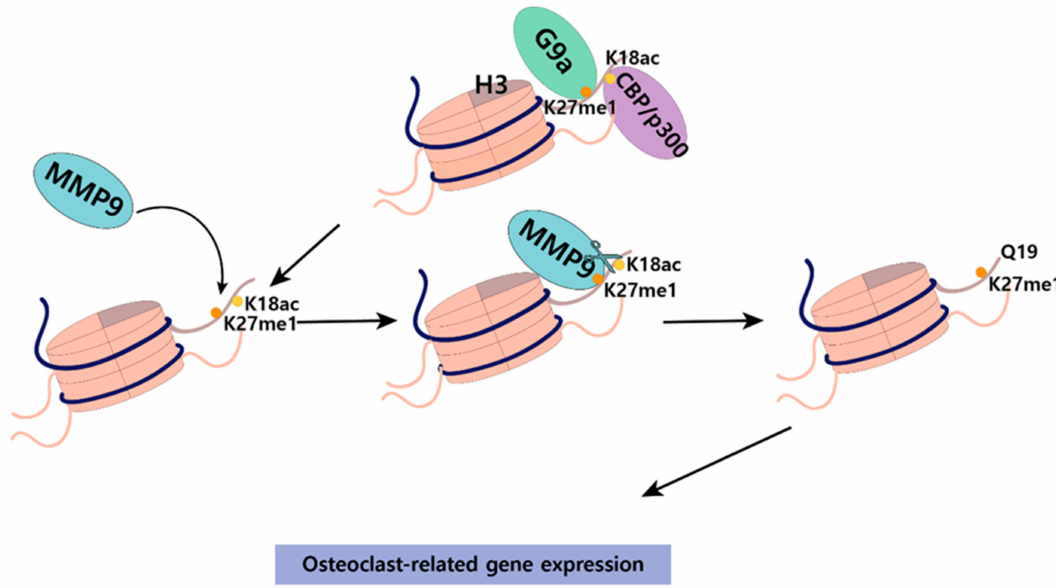
Figure 2. Schematic model of histone H3 N-terminal cleavage regulating osteoclastogenic target gene expression. G9a-mediated H3K27me1 at histone H3 enables matrix metalloproteinase-9 (MMP-9) to localizeattargetgenes. MMP-9catalyzeshistoneH3N-terminalproteolysis, leadingtoosteoclast-related gene expression. CBP / p300-mediated H3K18ac facilitates MMP-9 protease activity toward H3 N-terminal